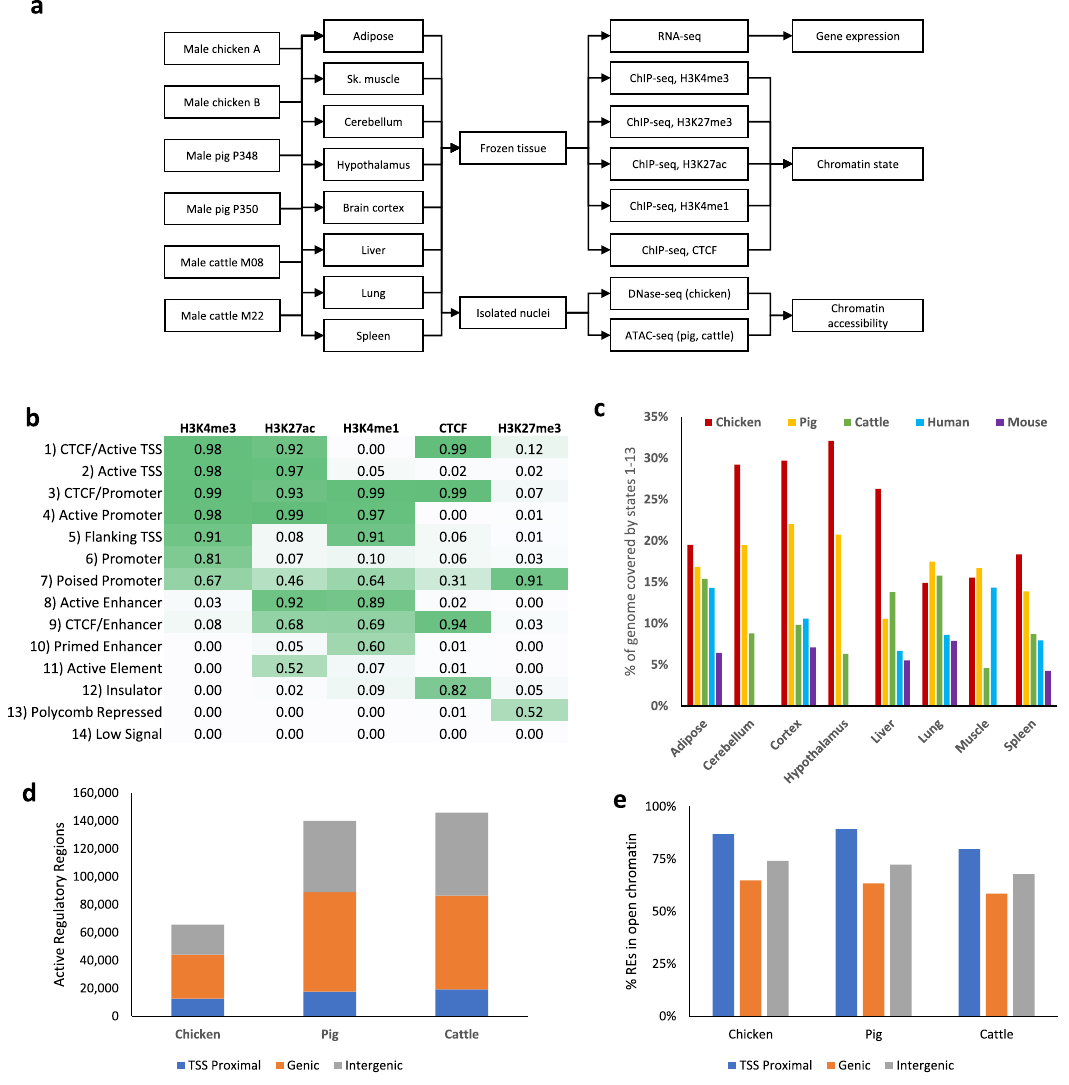
Fig. 1 ChromHMM integrates ChIP-seq data to predict chromatin states. a Experimental design schematic for the study. b Emission probabilities of the 14-state ChromHMM model. c Percent of the genome annotated with any functional state (any state except “ Low Signal ” ). d The number of regulatory elements identi fi ed in each species, separated by TSS proximal (within 2 kb of annotated TSS), genic (overlapping annotated gene body), and intergenic. e Percentage of regulatory elements that co-occurred with open chromatin in the tissues in which they were